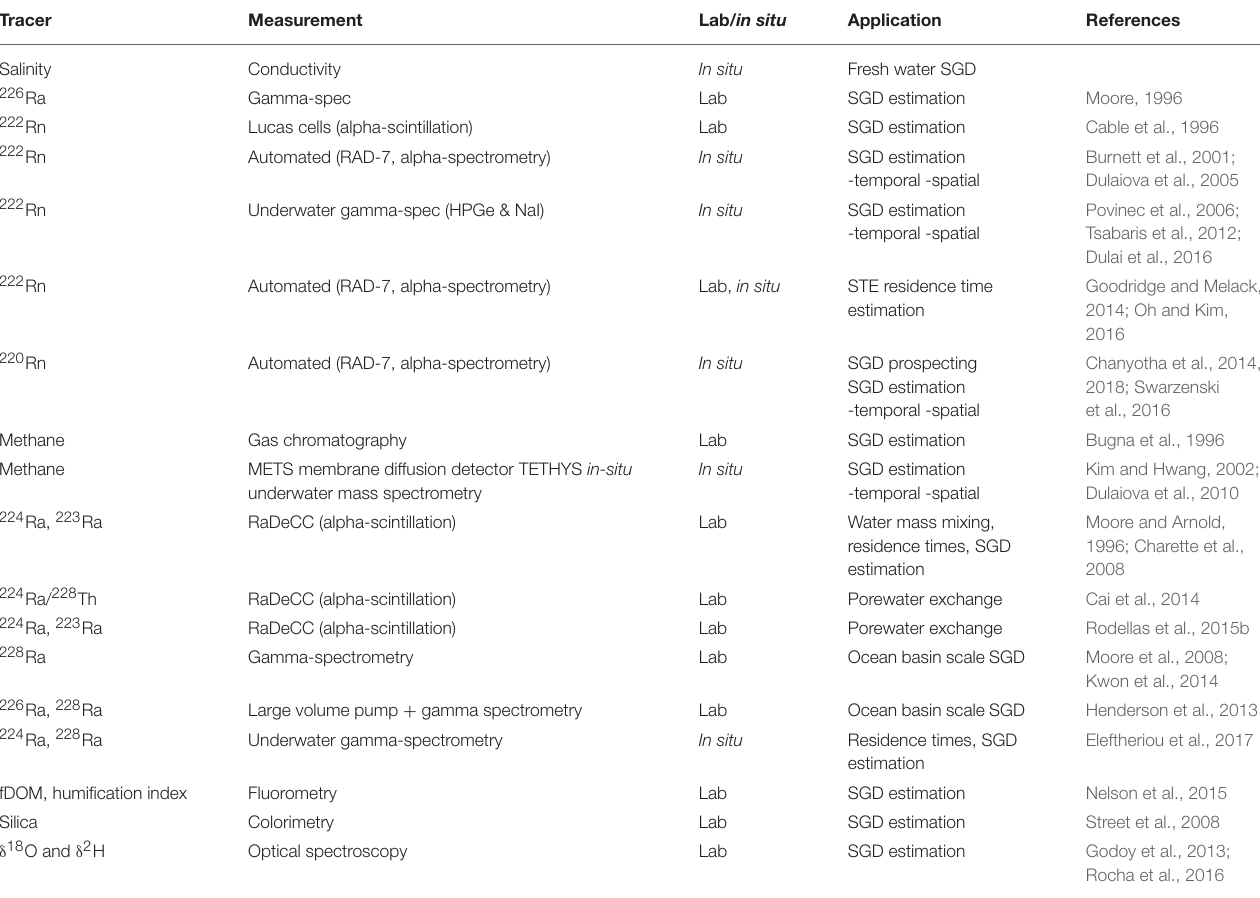
TABLE 1 | Summary of the main geochemical tracers used in SGD related